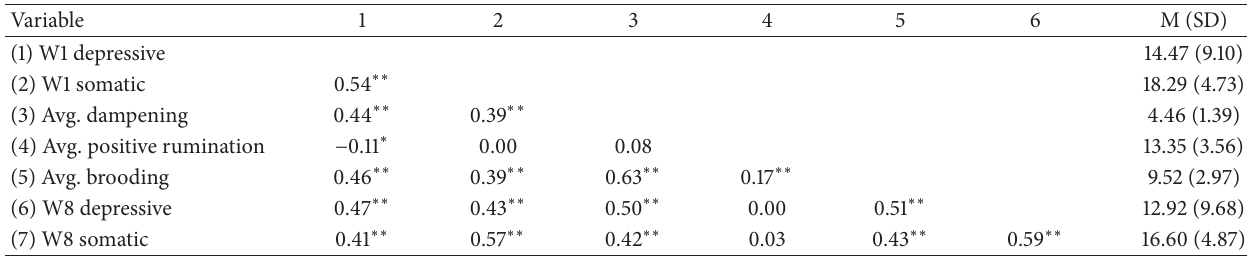
Table 1: Variable correlations and descriptors.